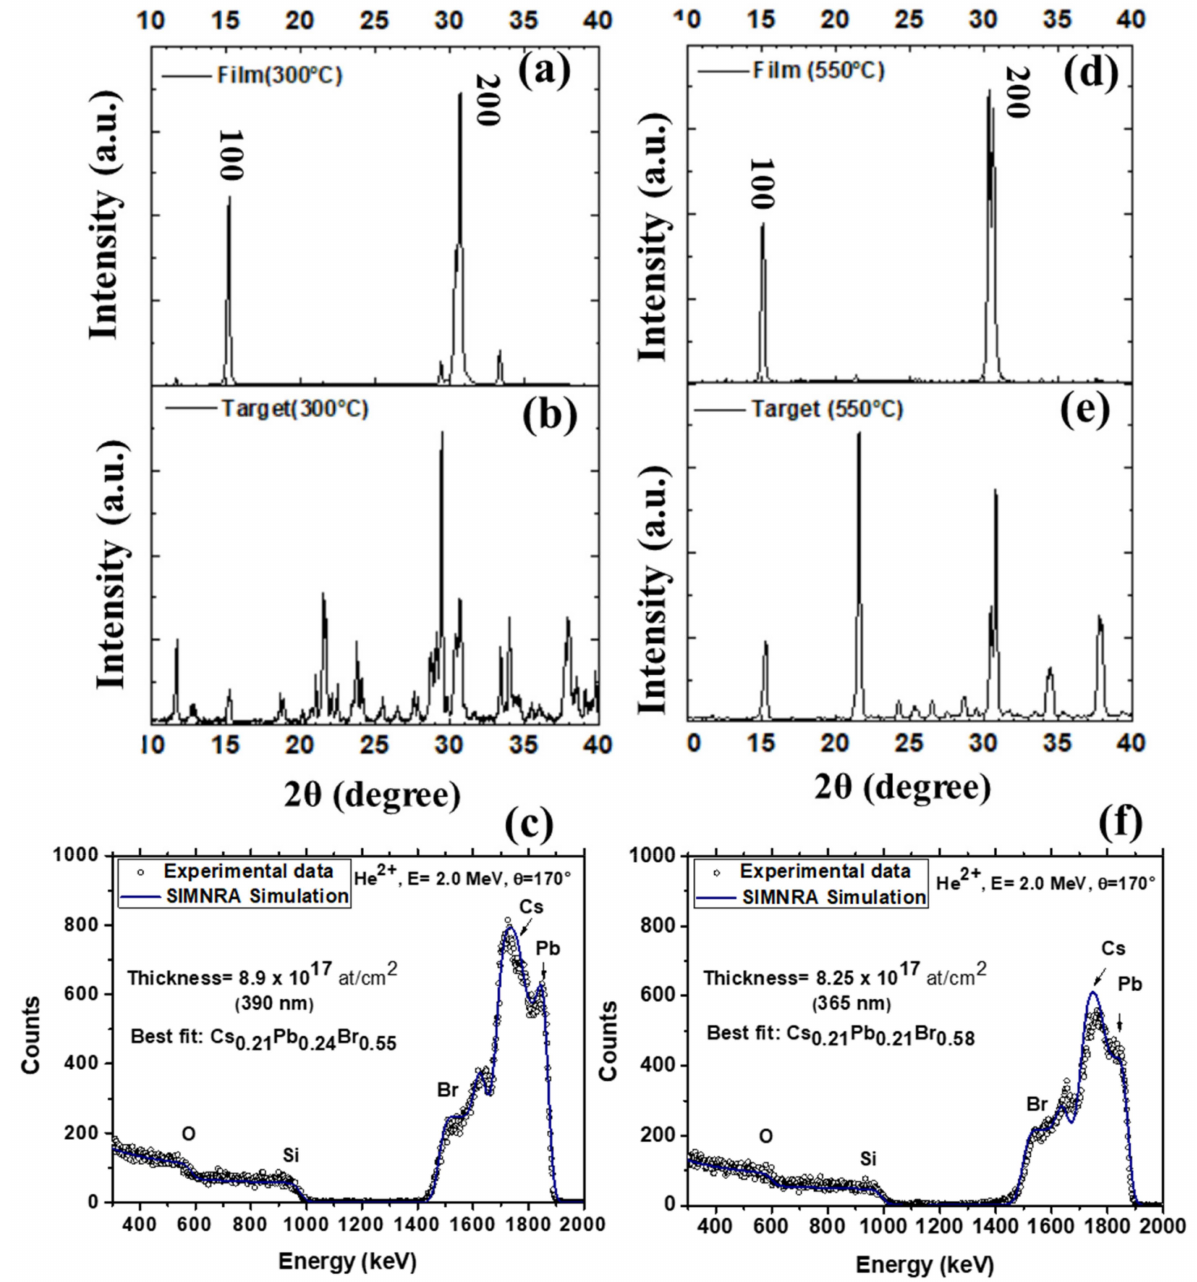
Figure 5. XRD and compositional RBS characterization of ( a – c ) Film (300 ◦ C) and associated Target (300 ◦ C) and ( d – f ) Film (550 ◦ C) and associated Target (550 ◦